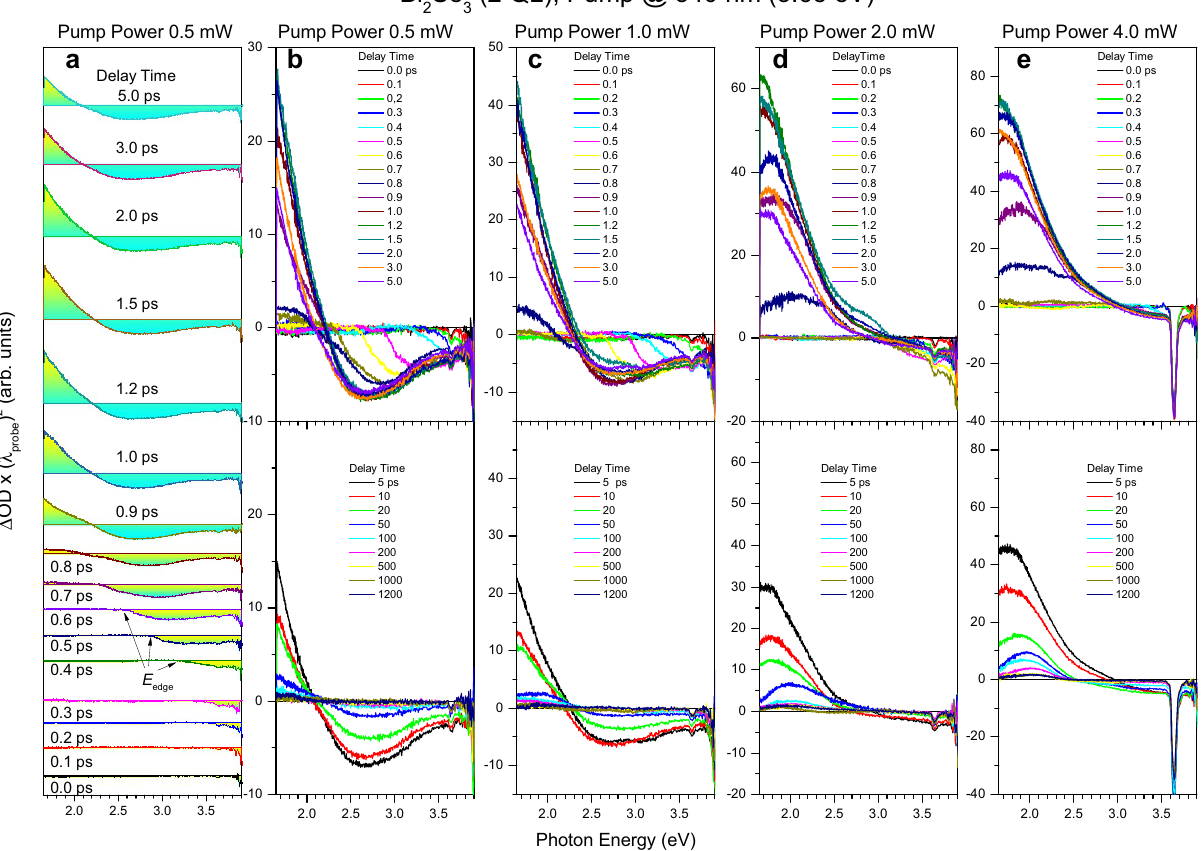
Figure 1. TA spectra of the topologically trivial insulator phase of the 2D TI Bi 2 Se 3 . ( a – e ) Set of TA spectra of the 2 QL thick Bi 2 Se 3 film measured at delay times indicated by the corresponding colors using the ∼ 340 nm pumping ( ∼ 3.65 eV photon energy) of different powers, as indicated for each of the columns. Part ( a ) and ( b ) show the same TA spectra for clarity. The zero-intensity lines of TA spectra in part ( a ) were shifted along the ΔOD axis (optical density change) for better observation. The factor (λ probe ) 2 in the ΔOD axis arises due to wavelength-to-energy units’ transformation. The low-energy edge of the transiently excited electron population ( E edge ) is indicated in part ( a